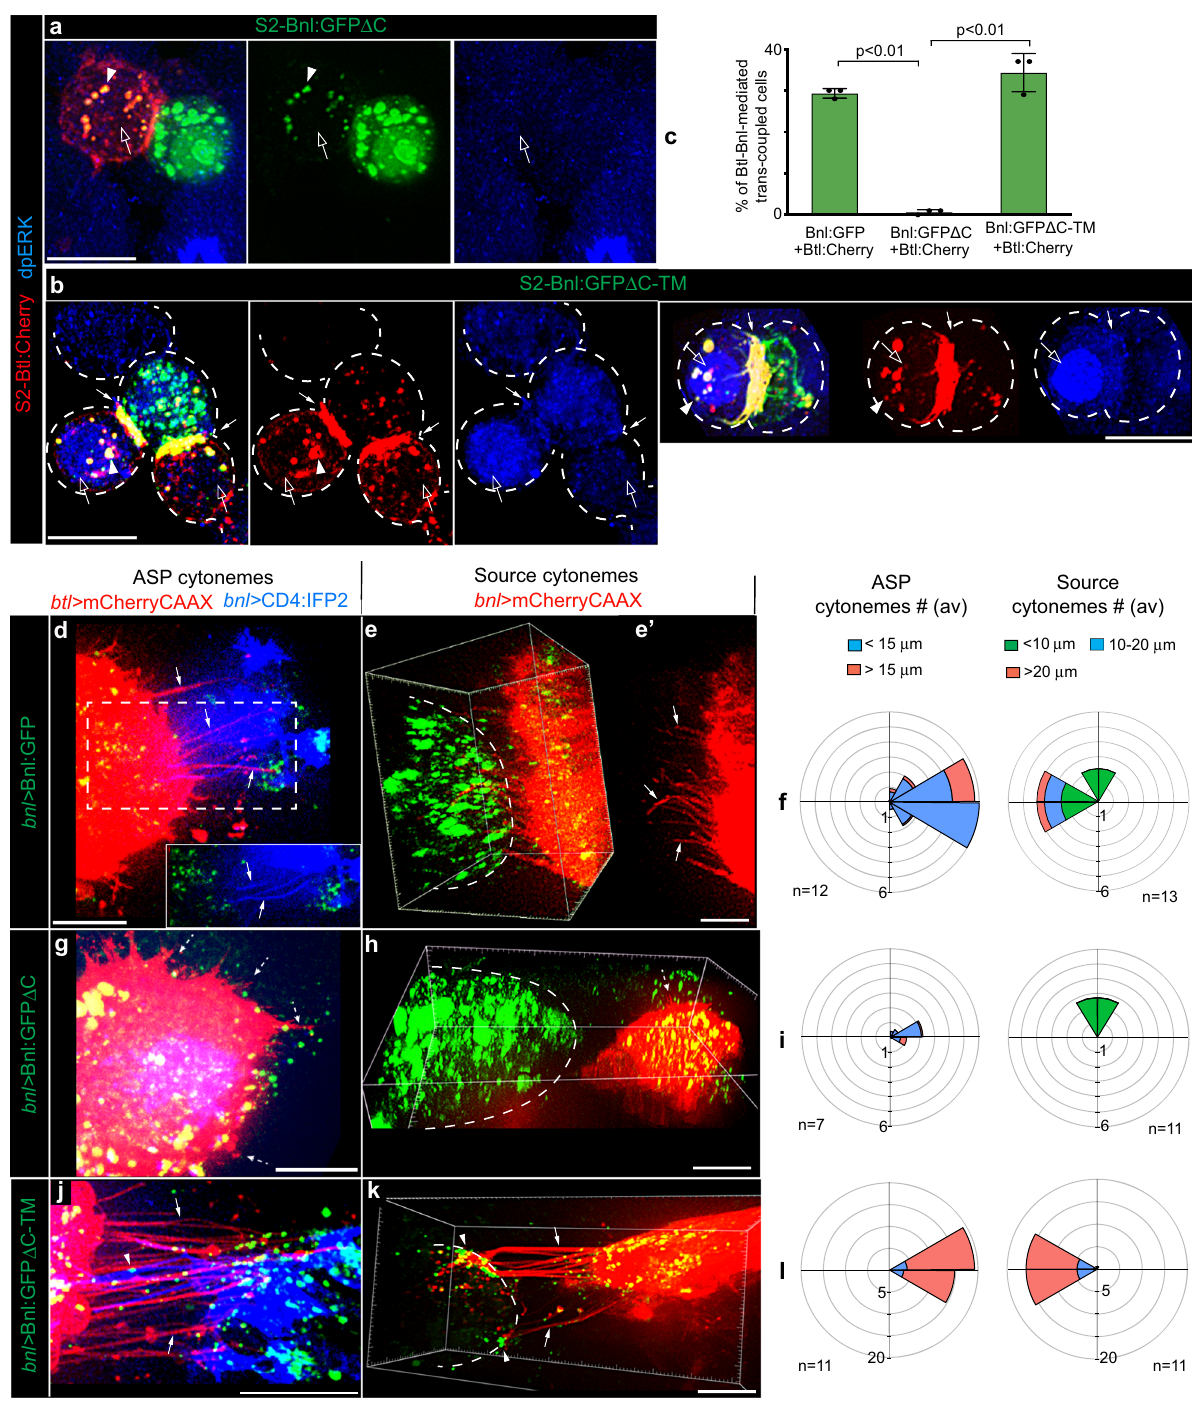
Fig. 6 GPI-anchored Bnl acts as a CAM. a – c CAM-like polarized trans-pairing of S2-Btl:Cherry with either S2-Bnl:GFP Δ C-TM ( b , c ) or S2-Bnl:GFP ( c ; see Fig. 3g, k) but not with S2-Bnl:GFP Δ C ( a , c ); arrow, polarized receptor-ligand co-clusters at the synaptic site; open arrow, nucleus in source